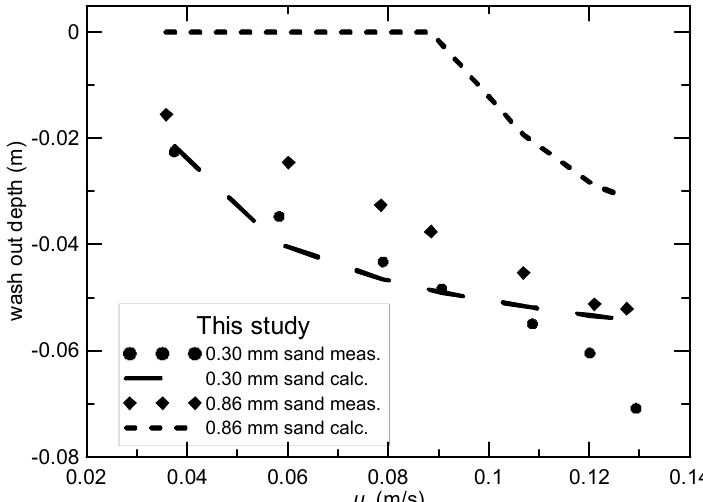
Fig. 3 Measured washout depths from the experiments and calculated values from equations (5) and